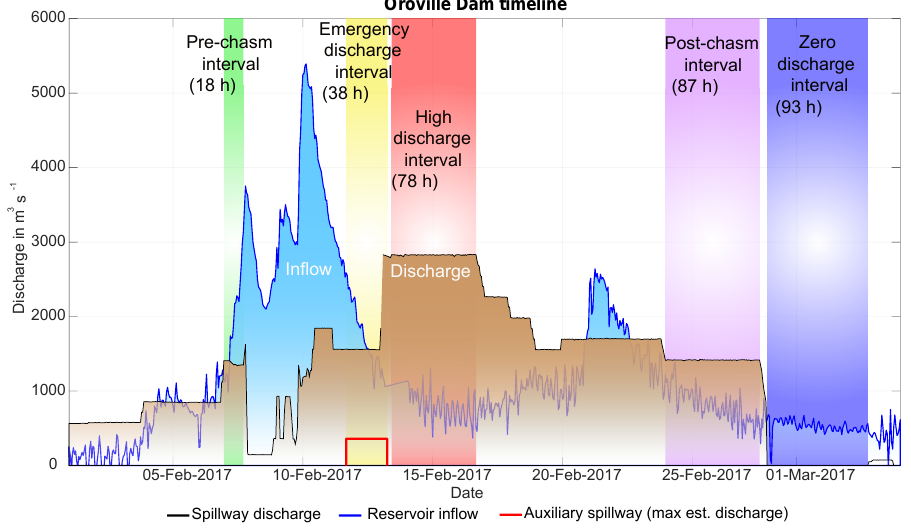
Figure 2. Discharge and inflow at Oroville Dam in early 2017, as reported by the California Department of Water Resources (CA DWR; Cal- ifornia Department of Water Resources, 2017d). The five time intervals of constant discharge in early 2017 used in this study are highlighted and labeled. The “Pre-chasm” and “Post-chasm” time intervals have approximately equal discharge, but very different channel geometries. Data gaps in discharge and inflow data are linearly interpolated in this figure. The inflows reported are from the Feather River to Lake Oroville. The discharge displayed for the emergency spillway weir is the maximum reported by CA DWR media updates, as no quantified measurements have been published for this